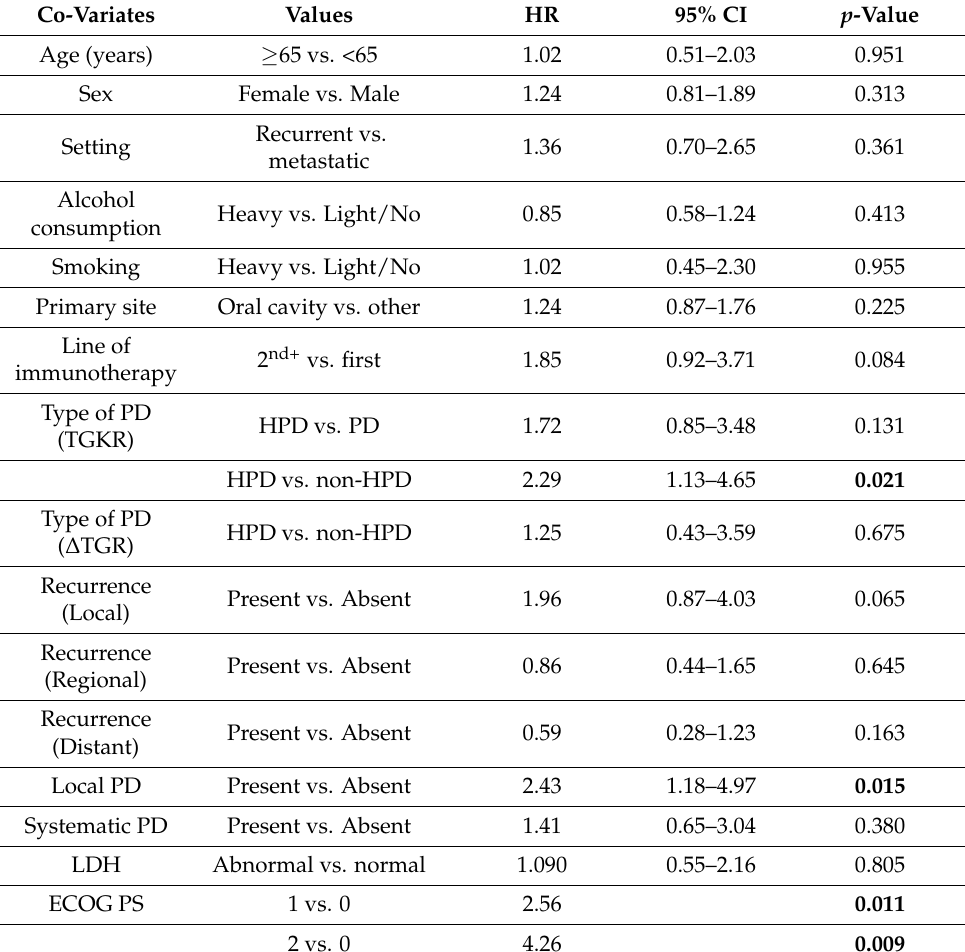
Table 1. Univariate cox proportional risk analysis for